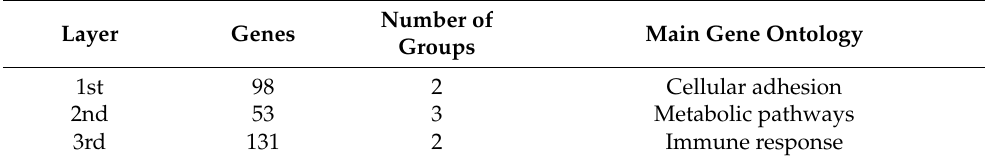
Table 1. Biological molecular layers obtained by the sparse K-means–consensus cluster workflow analyses and the number of groups into which CRC patients were divided according to each